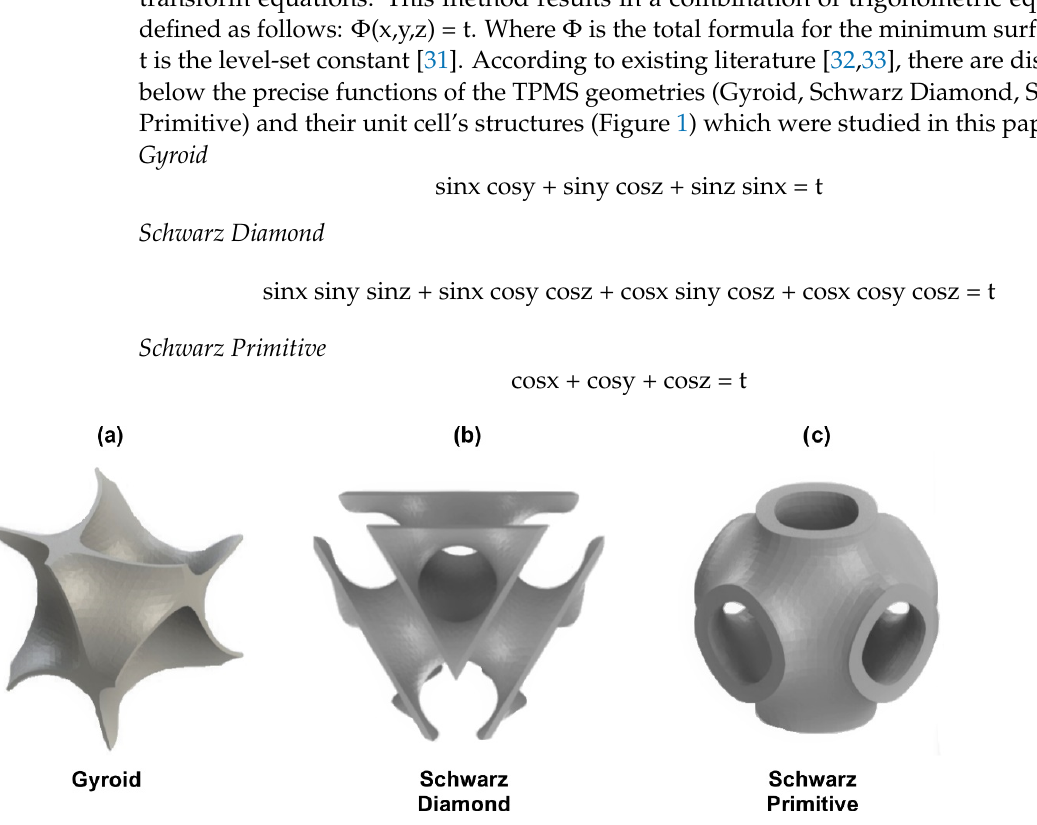
Figure 1. Unit cell of each Triply Periodic Minimal Surface (TPMS) structure: ( a ) Gyroid, ( b ) Schwarz Diamond (SD), ( c ) Schwarz Primitive (SP).